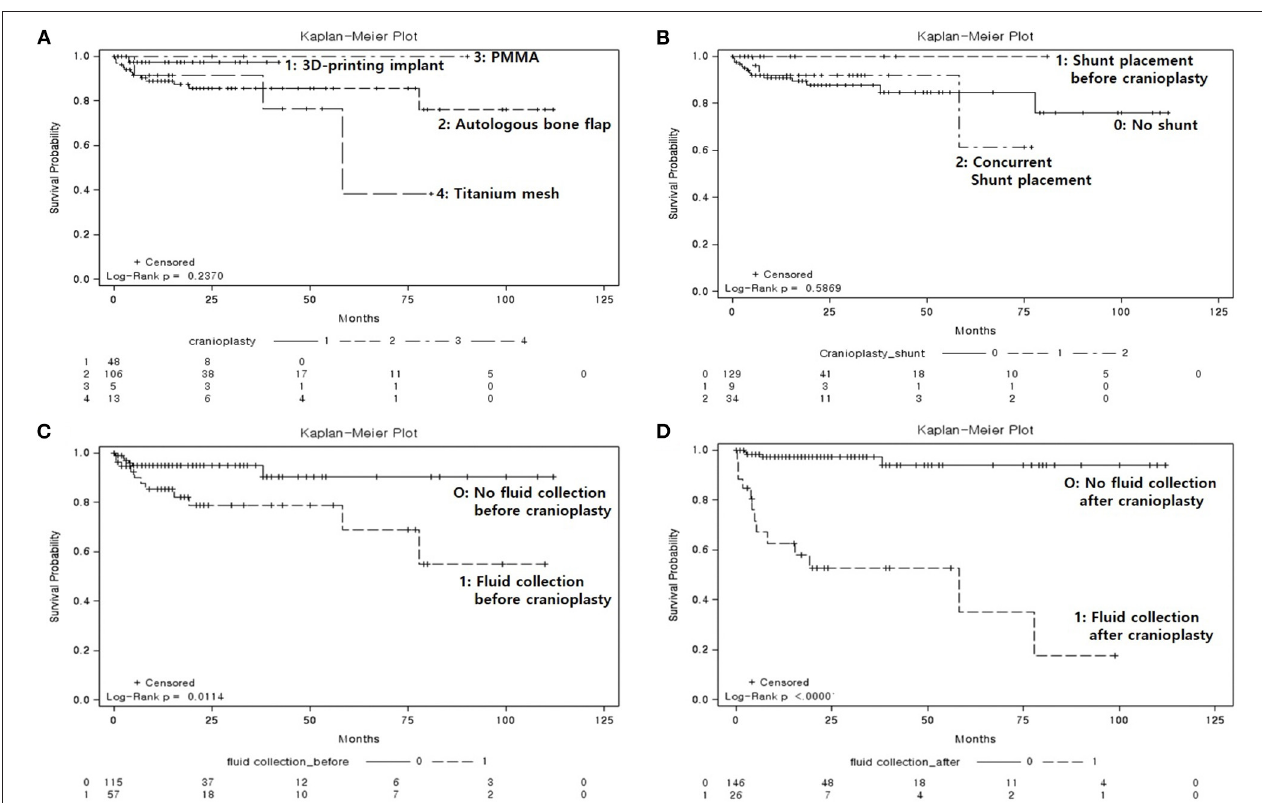
FIGURE 4 | Kaplan-Meier event-free survival curves for post-cranioplasty surgical site infection, according to clinical variables. (A) Graft materials ( p = 0.2370), 1: three-dimensional (3D) printed implant, 2: autologous bone flap, 3: polymethyl methacrylate, 4: titanium mesh. (B) Ventriculoperitoneal shunt ( p = 0.5869), 0: no shunt, 1: shunt in place prior to cranioplasty, 2: concurrent shunt placement. (C) Fluid collection on computed tomography (CT) scan prior to cranioplasty ( p = 0.0114), 0: no fluid collection, 1: fluid collection present. (D) Fluid collection on CT scan after cranioplasty ( p < 0.0000), 0: no fluid collection, 1: fluid collection